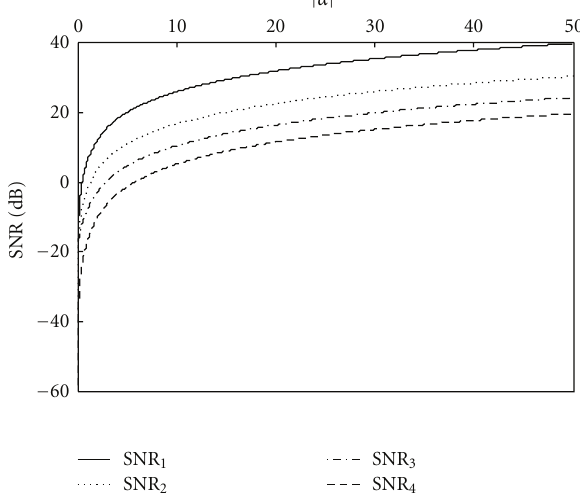
Figure 6: Signal-to-noise ratio for di ff erent order